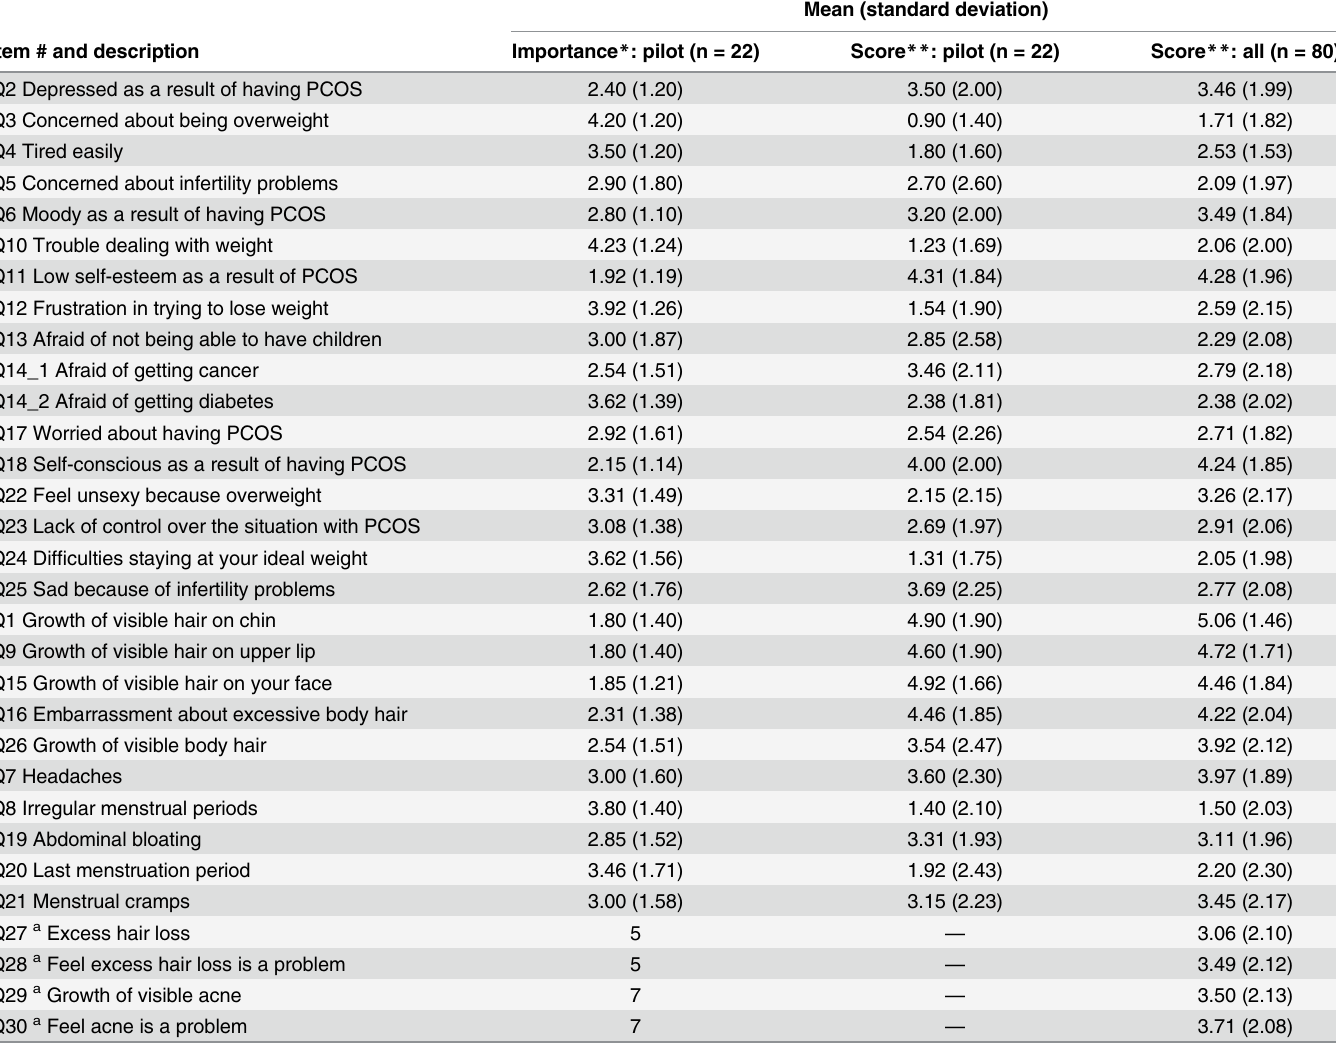
Table 2. Chi-PCOSQ scores and item